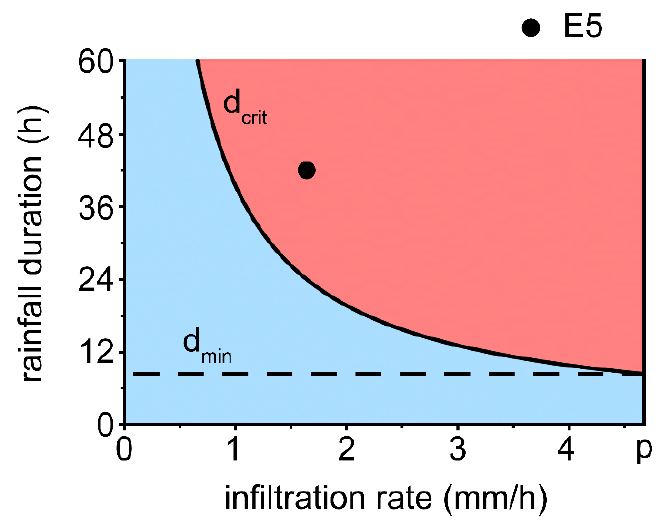
Figure 8. Critical curve calculated at the depth of the slip surface where u wo = − 0.70 kPa, with the point representing the rainfall event E5.